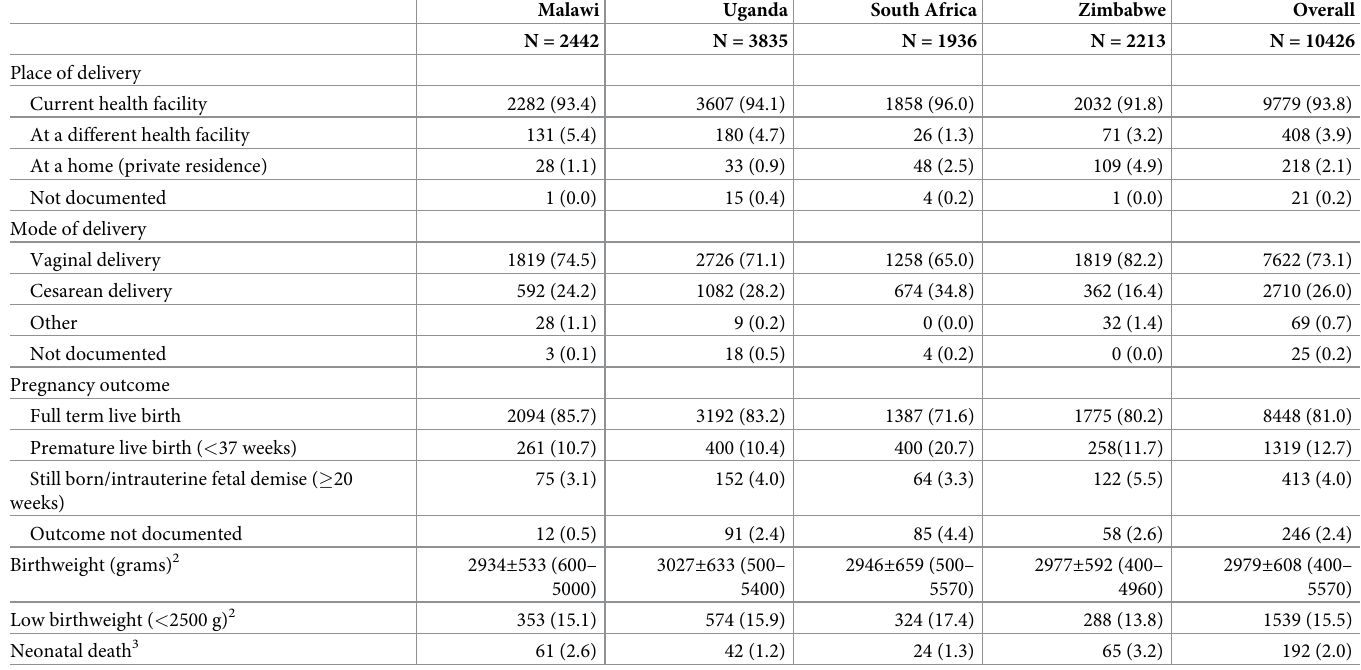
Table 4. Pregnancy outcomes and characteristics at